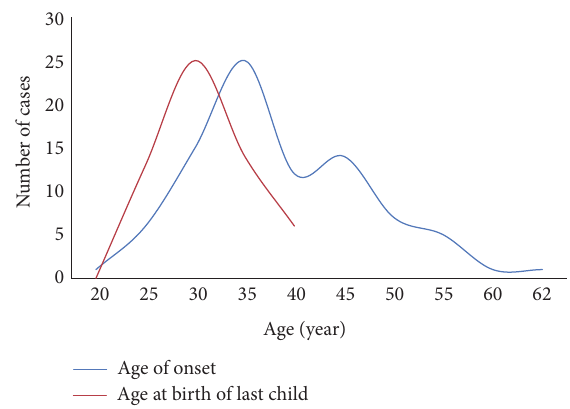
Figure 1: The distribution of age of onset and age at birth of first child. The median age of onset was 34 years, while the median age at birth of last child was 28 years. It seemed that there was a correlation between these two